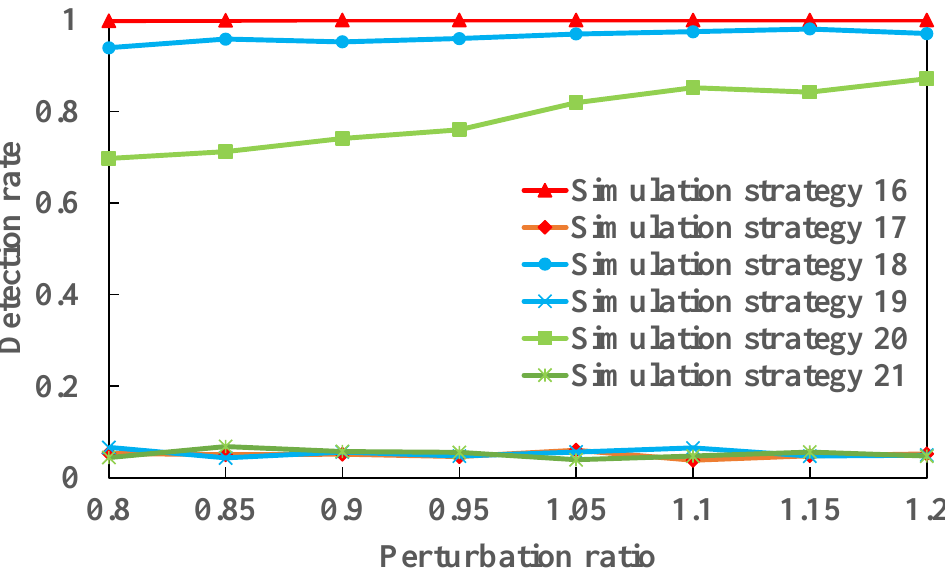
Figure 14. The detection rates in simulation strategies 16–21 when the perturbation ratio increases from 0.8 to 1.2.